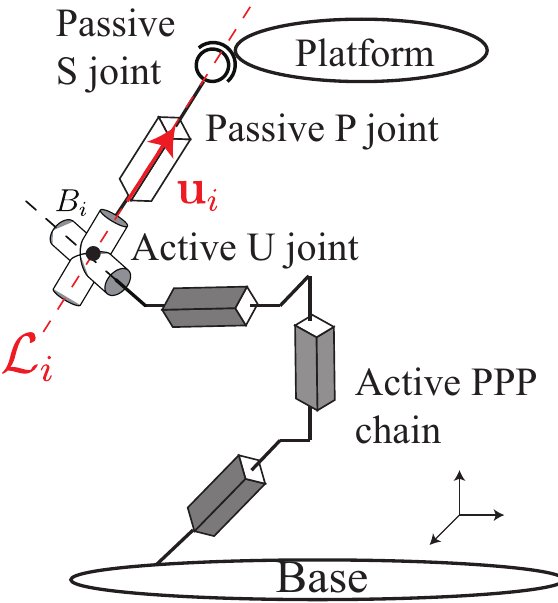
Figure 7. Corresponding hidden robot leg when the line L i in space is